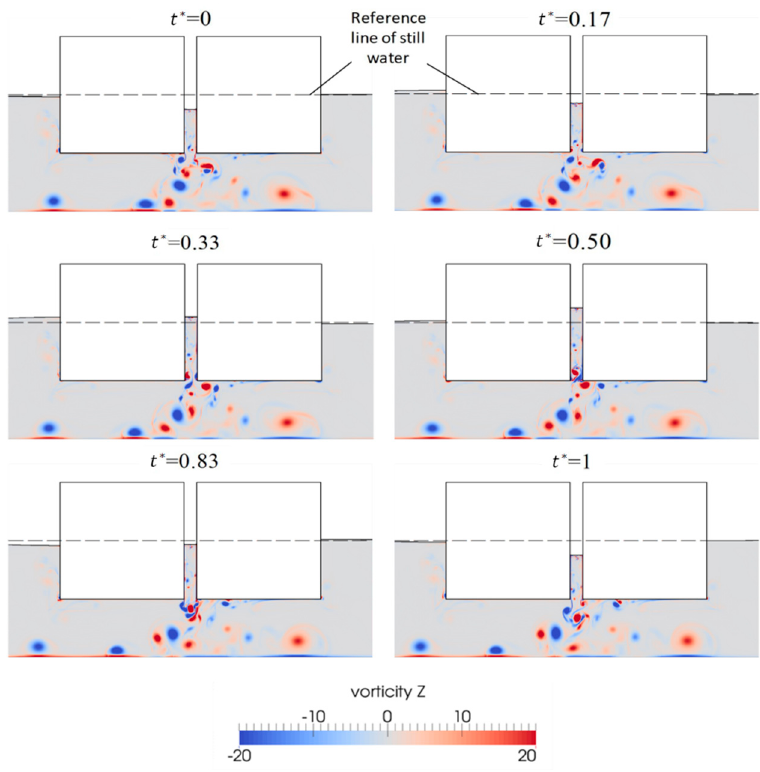
Figure 7. The variations of the vorticity contour in the water phase for Case C6 (incident wave frequency approaching the resonance) at different time instants.